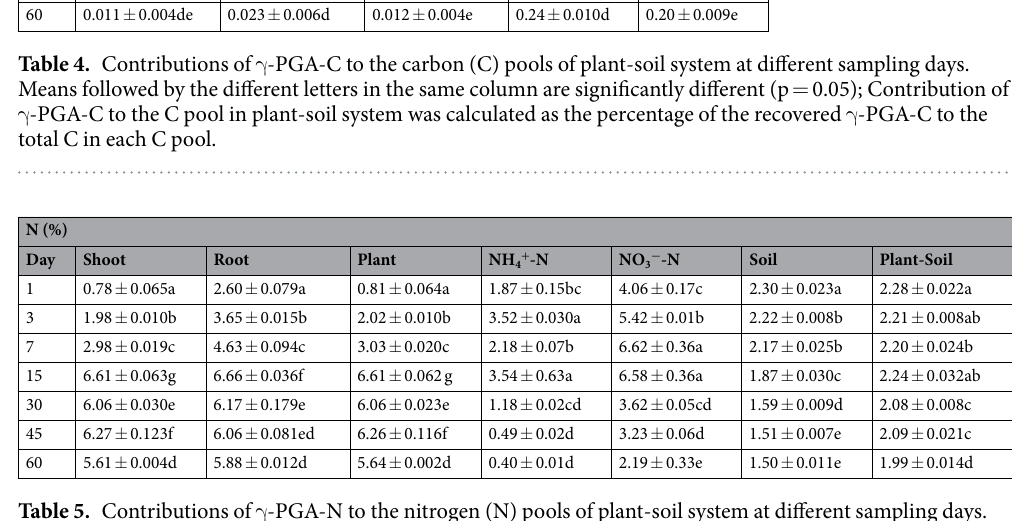
Table 5. Contributions of γ -PGA-N to the nitrogen (N) pools of plant-soil system at different sampling days. Means followed by the different letters in the same column are significantly different (p = 0.05); Contribution of γ -PGA-N to the N pool in plant-soil system was calculated as the percentage of the recovered γ -PGA-N to the total N in each N